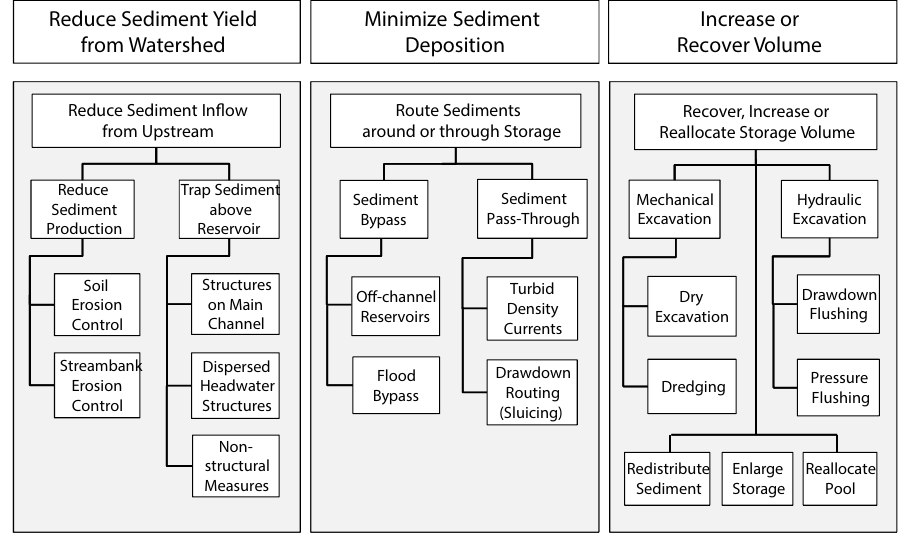
Figure 1. Sustainable sediment management strategies, as categorized by Morris and Fan [5] and Kantoush and Sumi